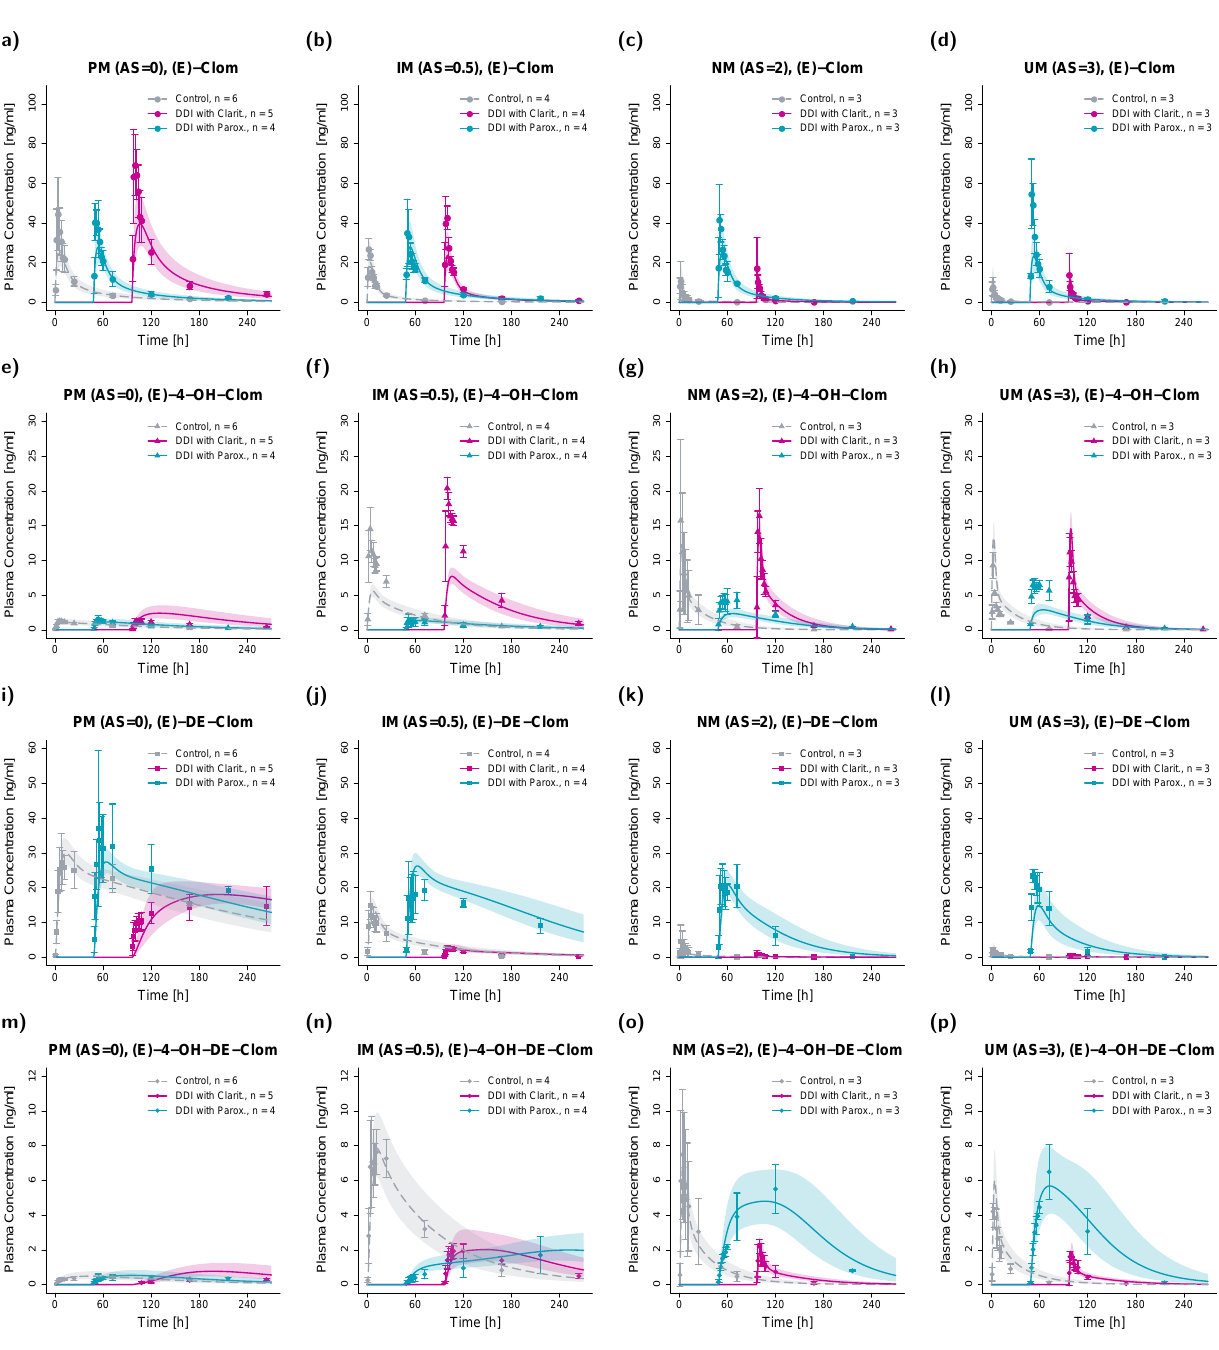
Figure 6. Predicted and observed plasma concentration–time profiles of ( E )-Clom ( a – d ), ( E )-4-OH- 1 Clom ( e – h ), ( E )-DE-Clom ( i – l ) and ( E )-4-OH-DE-Clom ( m – p ) for DD(G)I scenarios in PM (first column), IM (only AS = 0.5 shown; second column), NM (third column) and UM (last column). Grey dashed lines depict the predicted geometric mean concentration–time profiles in absence of clarithromycin and paroxetine (control); turquoise solid lines represent the predicted geometric mean profiles in the presence of paroxetine; and pink solid lines represent the predicted geometric mean profiles in the presence of clarithromycin (DD(G)I). Colored ribbons show the corresponding geometric standard deviation of the population simulations ( n = 1000). Mean observed data are shown as symbols with the corresponding standard deviation. Linear and semilogarithmic predicted and observed plasma concentration–time profiles of all AS are shown in Section S4.2 of the supplementary document. For better visibility, DD(G)I scenarios were plotted with a time offset with t = 0 at the first dose of the perpetrator drug. AS, CYP2D6 activity score; Clarit., Clarithromycin; DD(G)I,